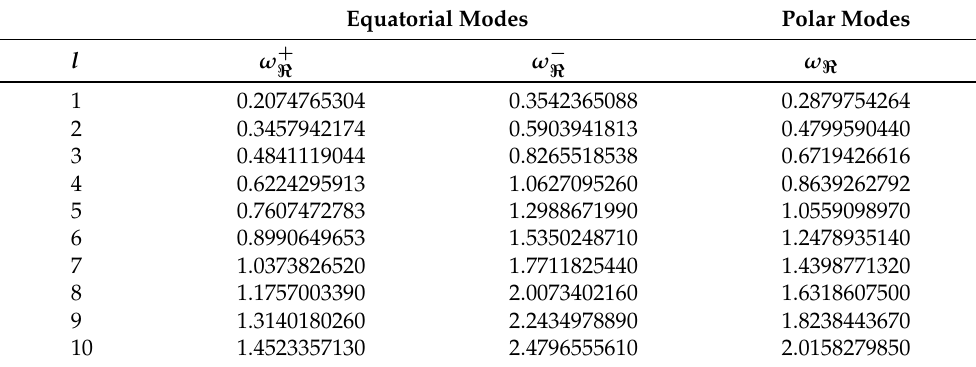
Table 1. Numerical values of the real part of QNMs for equatorial modes and polar modes. We have set a = 0.5 [ M ] and b = 0.5 [ M ]